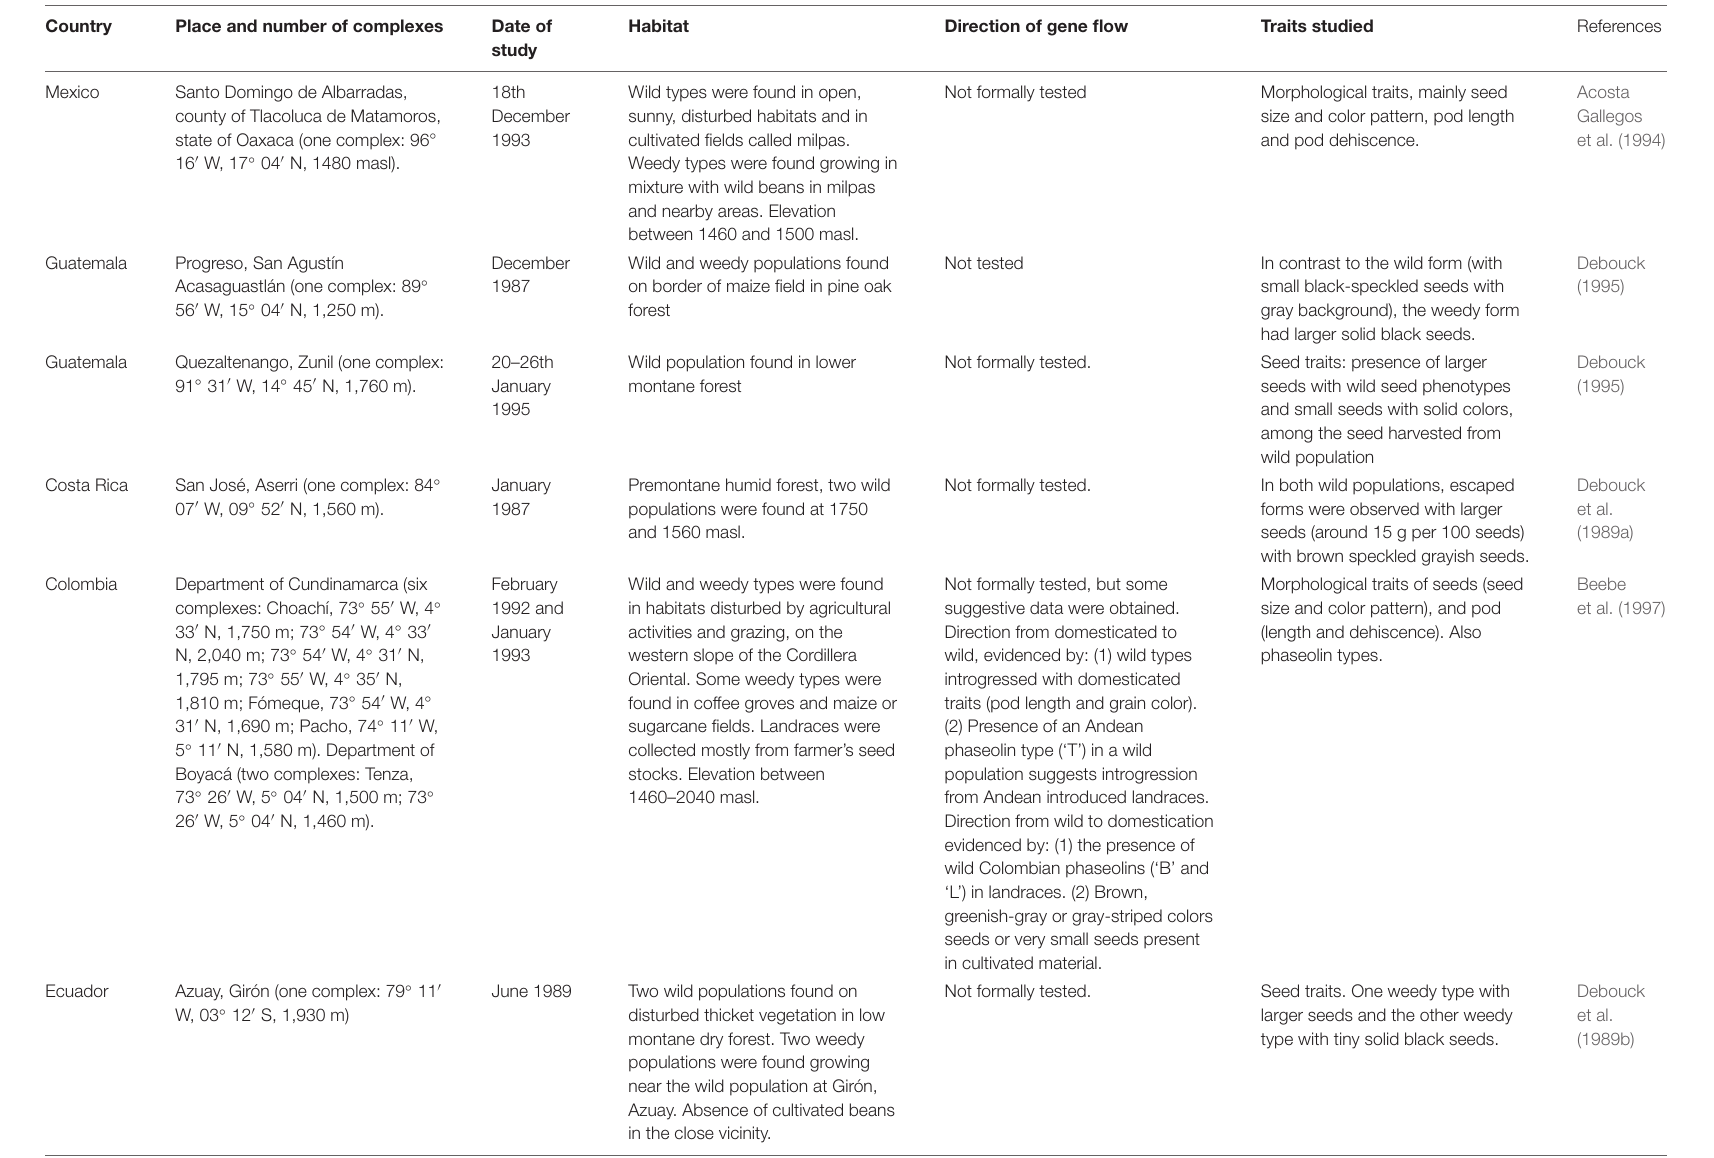
TABLE 4 | Wild-weedy-crop complexes reported in common bean in Mesoamerica and the